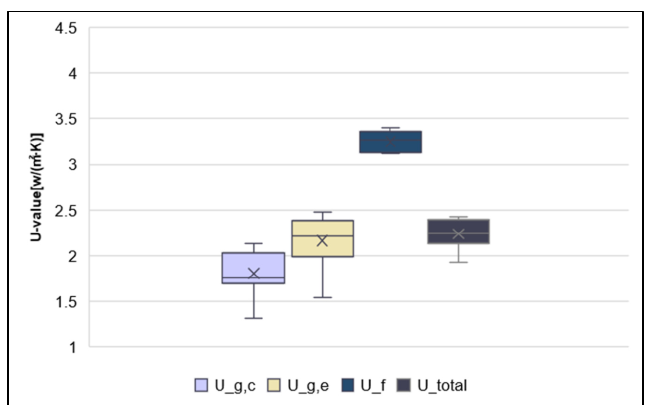
Figure 27. Boxplot of U-value Results Using IR Case 2 [36].